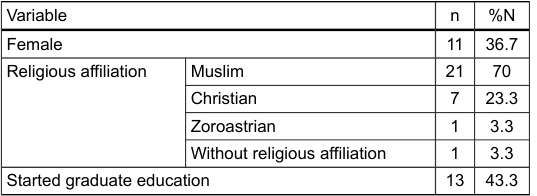
Table 1: Participants’ demographics.